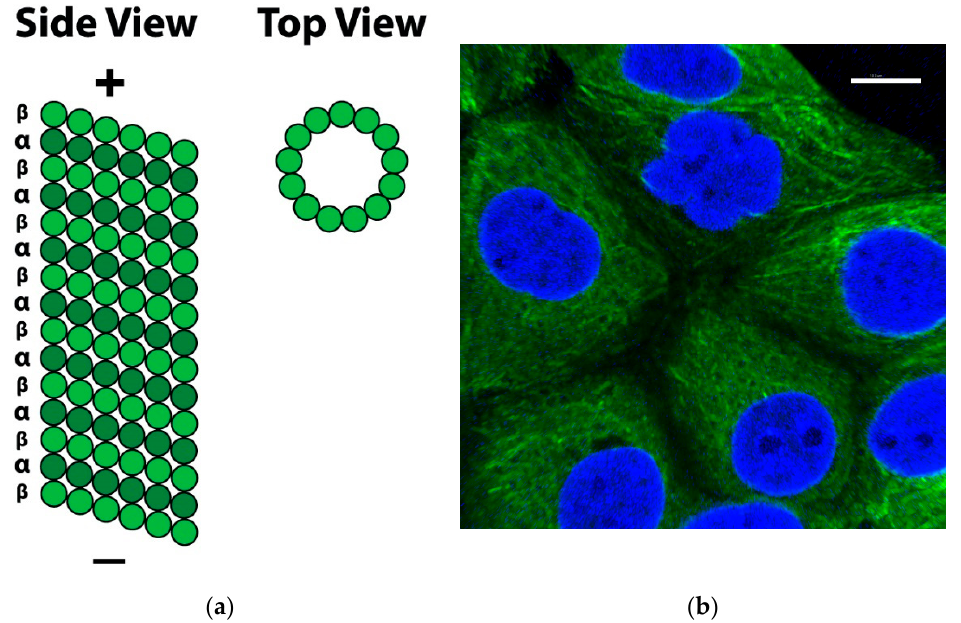
Figure 1. Microtubule structure from side and top perspectives. ( a ): Side View: Long, linear protofilaments consisting of αβ -tubulin heterodimers associate laterally; Top View: Association of 13 protofilaments forms the microtubule, a long hollow cylinder. ( b ): Microtubule network in MCF-7 breast cancer cells. Cells were stained with mouse monoclonal anti- α -tubulin − fluorescein isothiocyanate (FITC) antibody (clone DM1A) (tubulin, green) and Alexa Fluor 488 dye, then counterstained with 4 ′ ,6-diamidino-2-phenylindole (DAPI) (nuclei, blue). Scale bar: 10 μ M.